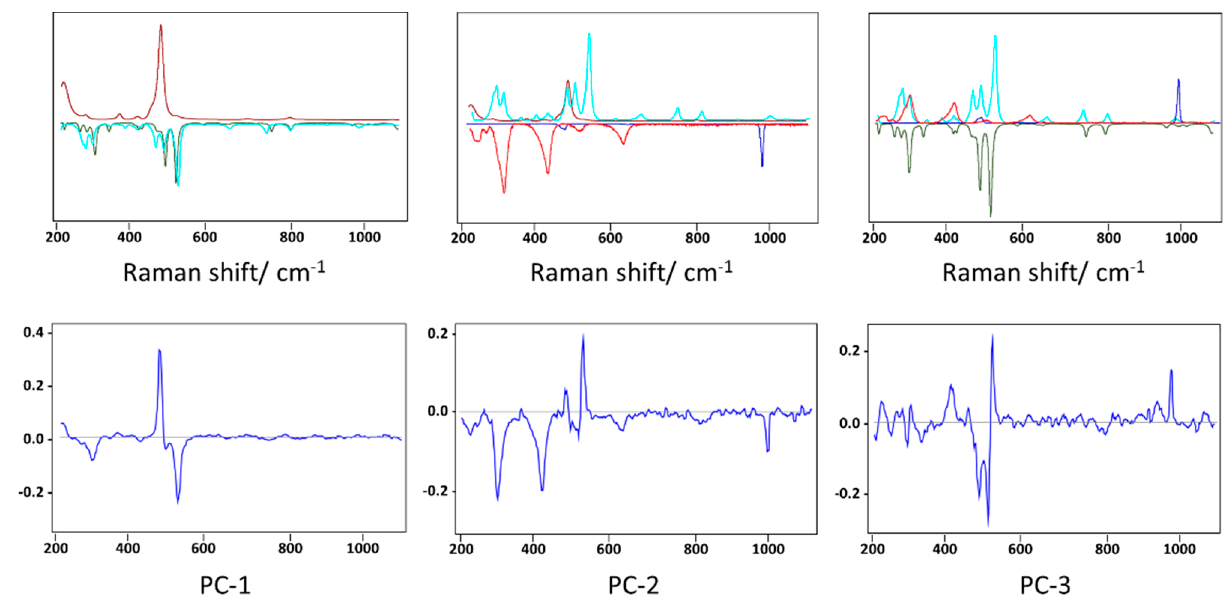
Figure 5. PCA loadings resulting from the analysis of the Raman spectra of the core section of the studied fulgurite ( bottom ) as compared with the Raman spectra of the relevant minerals ( top ). The colors of the spectra of the minerals are the same as those shown in Figure 3.